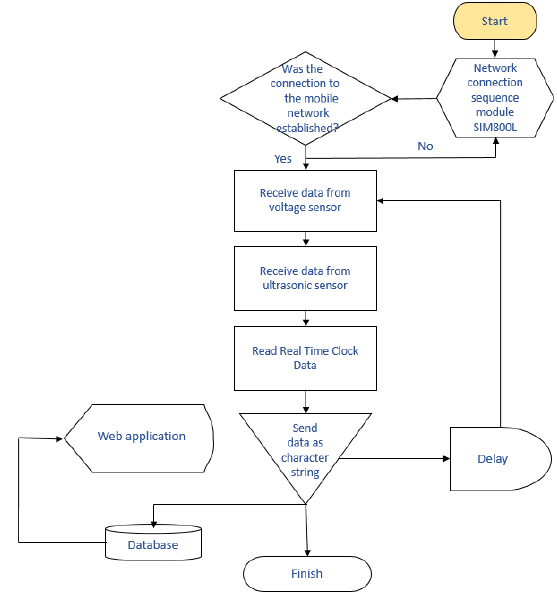
Fig.1. Software design flow chart.